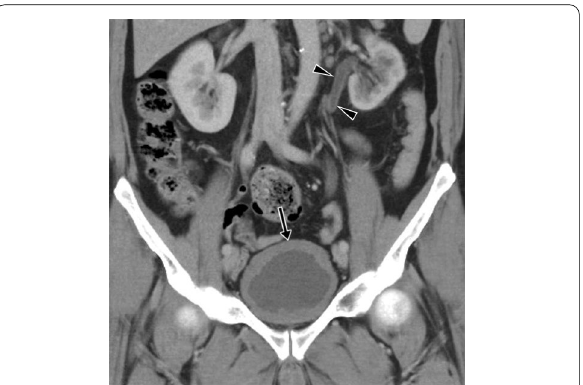
Fig. 38 A 47-year-old male. Coronal post-contrast CT scan shows diffuse thickening of the bladder wall (arrow) and dilated left proximal ureter (arrowheads). Urinary